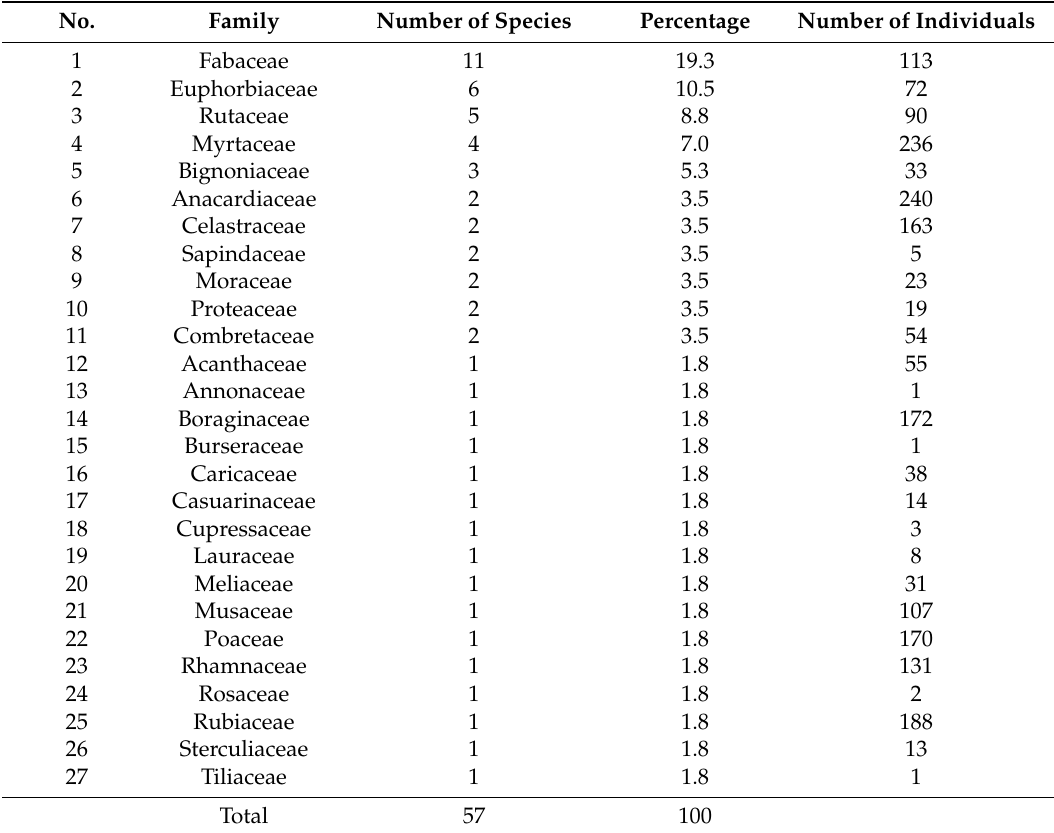
Table 3. Woody and herbaceous perennial species and corresponding families identified in home gardens and parkland agroforestry systems in Assosa district, western Ethiopia.